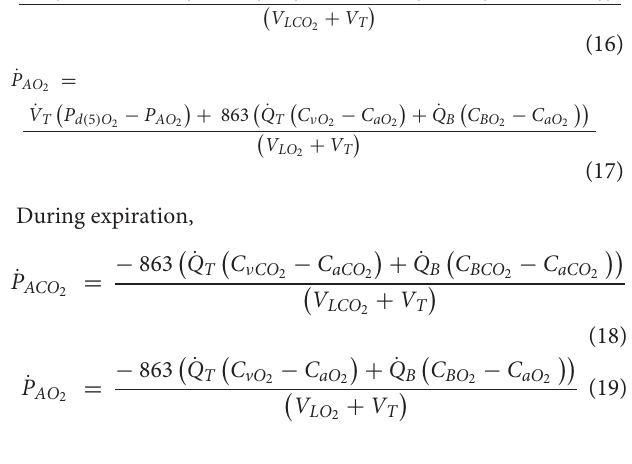
FIGURE 2 | Schematic diagram of the proposed respiratory system model RS3. A model based on RS2 (Cheng et al., 2010; Cheng and Khoo, 2012) that integrates key features of RS1 (Fincham and Tehrani, 1983). The changes introduced in RS2 have been highlighted in orange. In the model, mean values of P ′ aCO P bCO ( P m ) and a metabolically related neural drive component to the ventilation (MRV) are used by the central neural control system to compute the alveolar 2 ventilation ( ˙ V A ) and the total ventilatory drive ( D T ≡ ˙ V E = ˙ V A + ˙ V D ). Then, ˙ V A is used to adjust the respiratory frequency ( f R ) each breathing cycle following the optimization principle set in Otis et al. (1950). A detailed description of model variables is provided in the Supplementary Material Section (Table